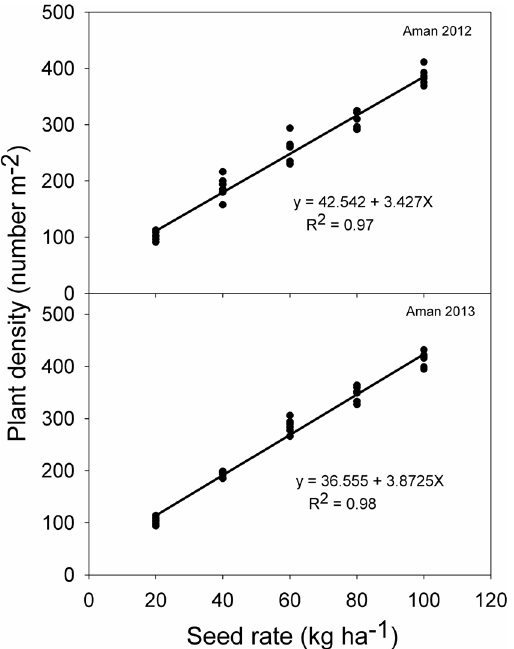
Figure 2. Relationship between rice seeding rate and rice plant density at 14 days after sowing in 2012 and 2013.